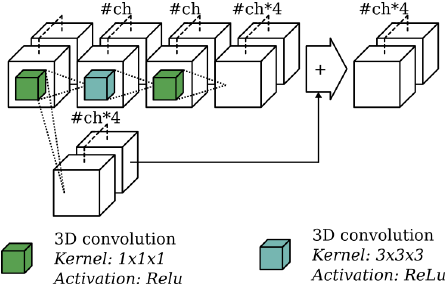
Figure 4. Overview of the basic building block used in ScanComplete where # ch is a parameter value describing the number of channels used for the 3D convolutions and # in represents the number of input channels of the first convolution.